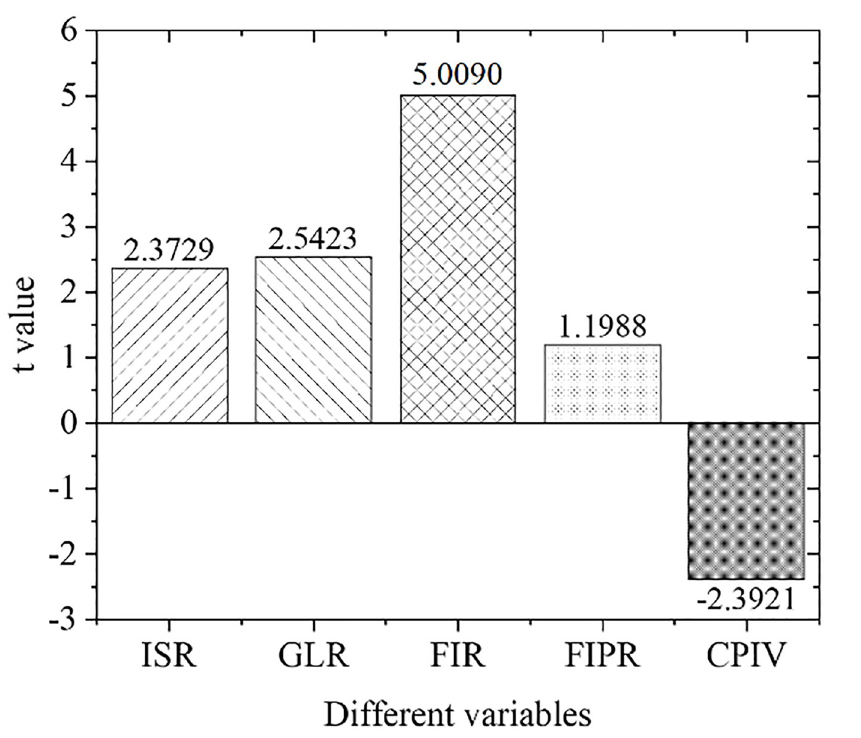
Fig 16. Robustness analysis results (t-value in the eastern region).